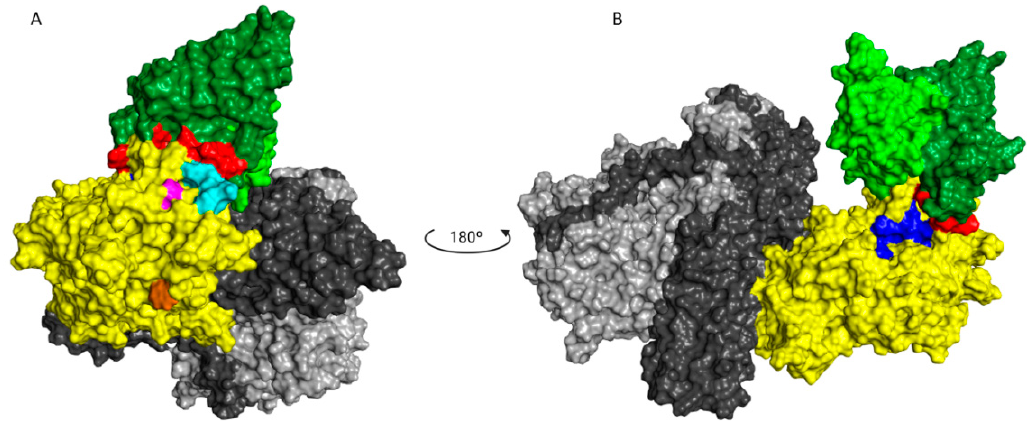
Figure 6. Molecular docking. ( A ) Front of the TT-140-TeNT complex showing the interaction of mAb and epitope predicted by peptide array. ( B ) TT-140-TeNT complex rotated 180° showing the proximity of TT-140 to the predicted epitope of TT-117. In green, the mAb TT-140 (heavy chain in dark green and light chain in light green) with antigen binding residues highlighted in red. In cyan, the TT-140 epitope prediction by the peptide array is shown. The W and R pockets are shown in brown and pink, respectively. Fragment C of TeNT is marked in yellow, the L domain in light grey, and H in dark grey. The TT-117 linear epitope 1119-1128 indicated by the peptide array is shown in blue.